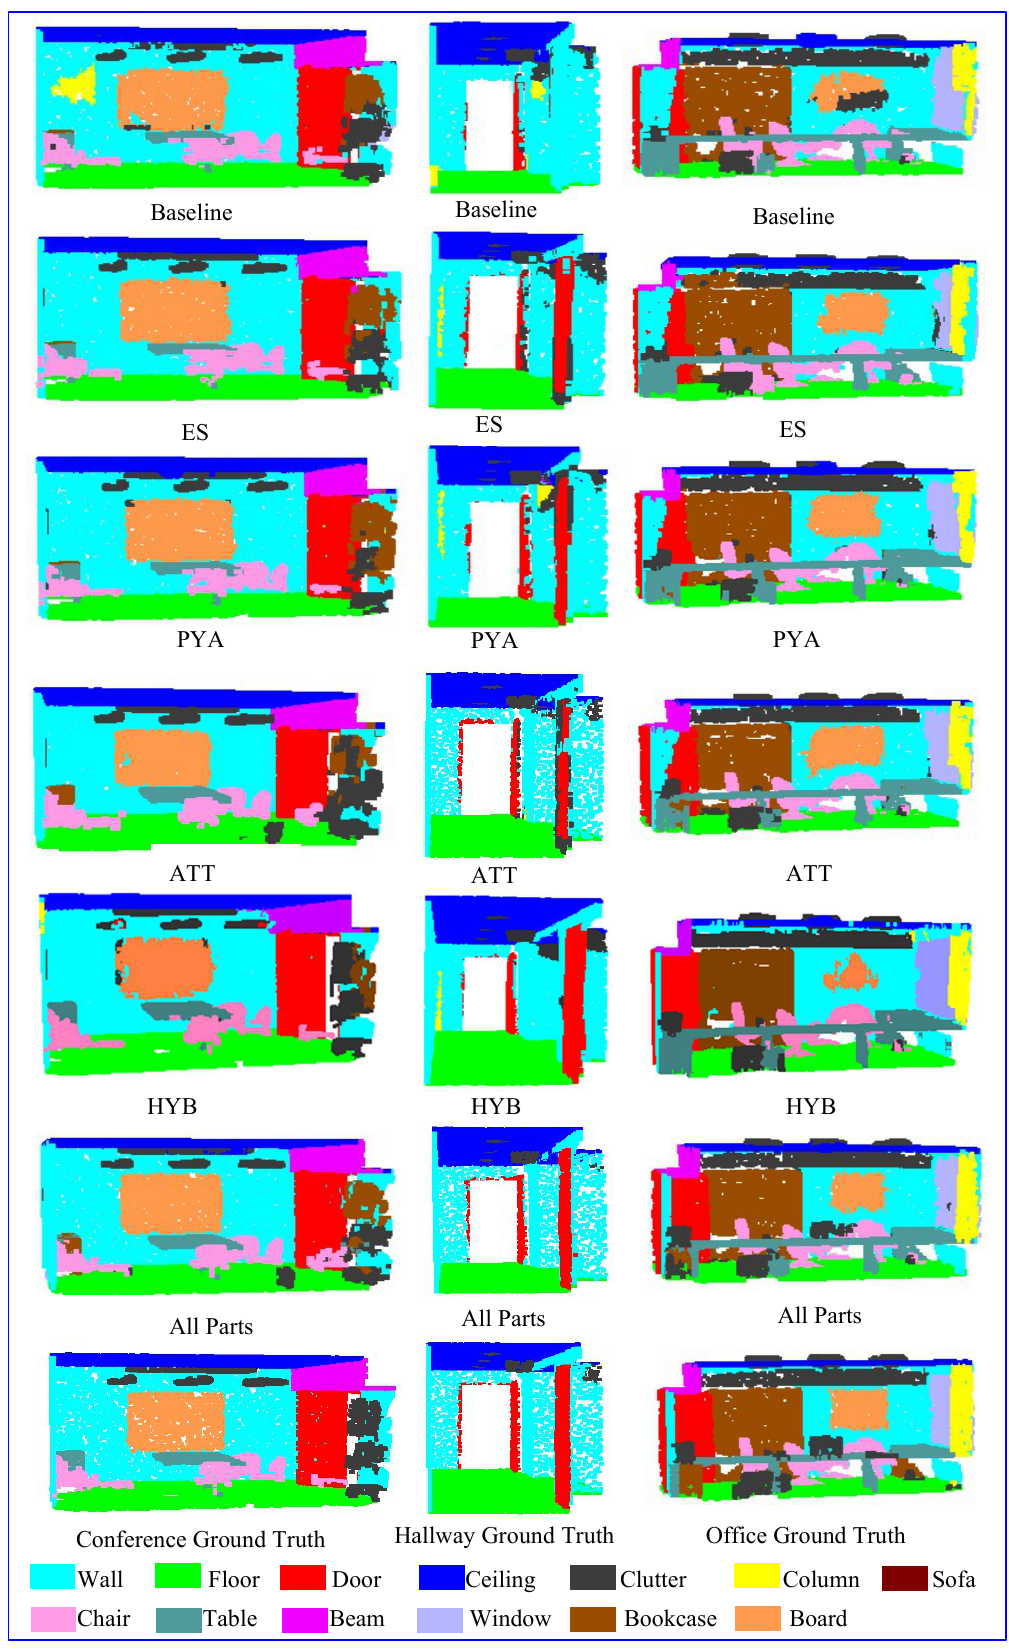
Figure 6. Comparison of visualization results of partial scene